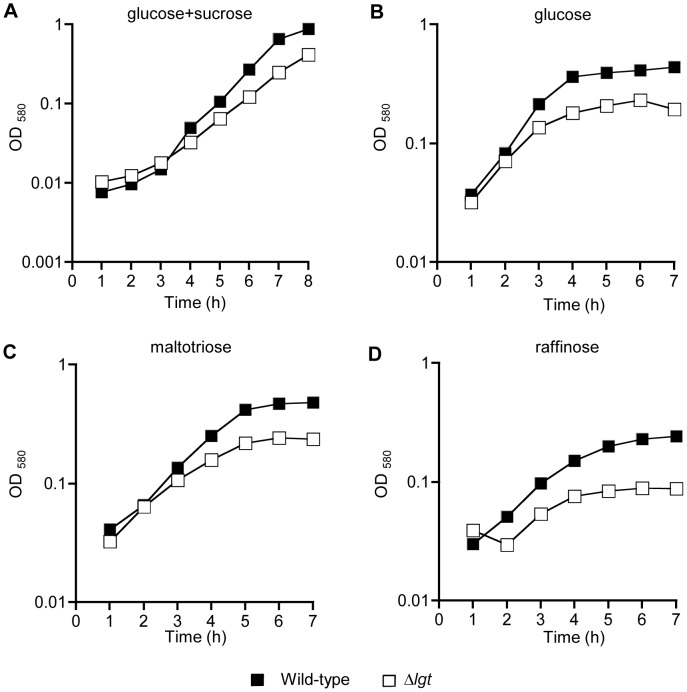
Growth of the wild-type and Δlgt strains in restricted carbohydrate sources.Assessed by measuring broth culture log10 OD580 over time. (A) C+Y medium supplemented with 10 mM sucrose and glucose each; (B) C+Y medium supplemented with 10 mM glucose; (C) C+Y medium supplemented with 10 mM maltotriose; and (D) C+Y medium supplemented with 10 mM raffinose. Error bars represent SDs, and when not visible are within the symbol. Filled symbols represent growth of the wild-type strain, empty symbols growth of the Δlgt strain.